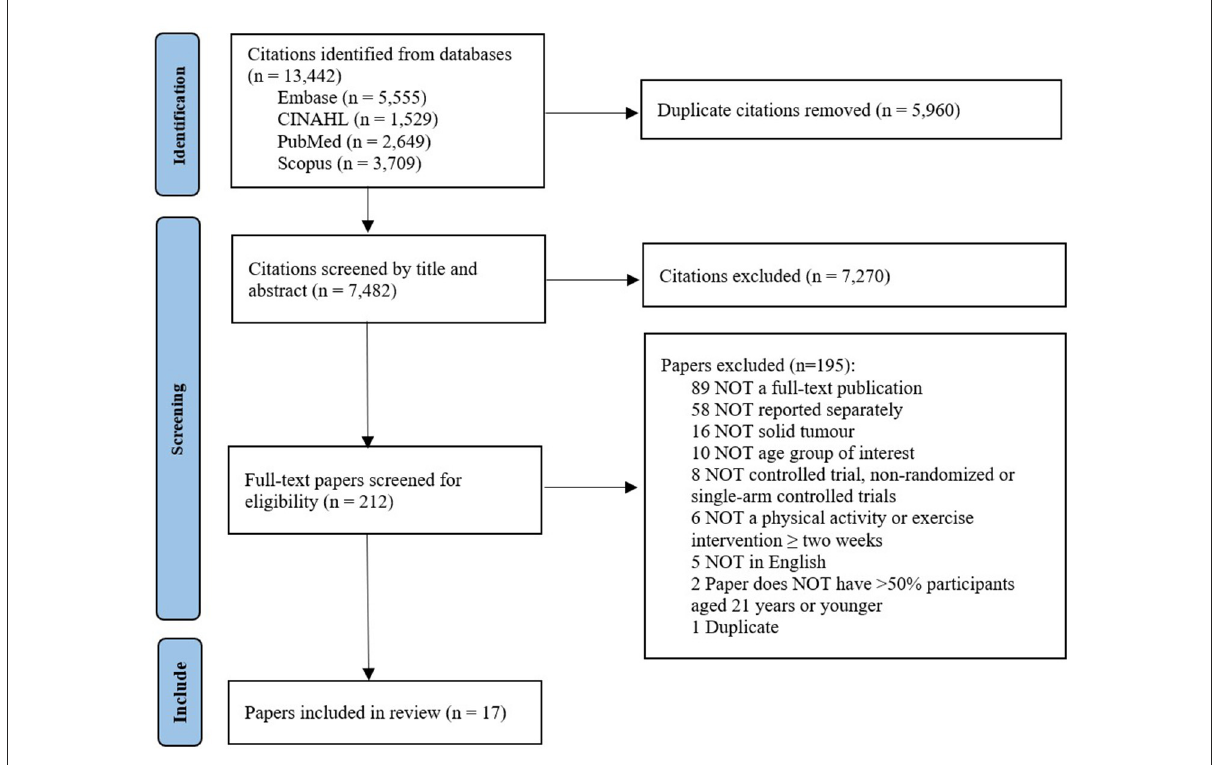
FIGURE1 Flow chart of included and excluded